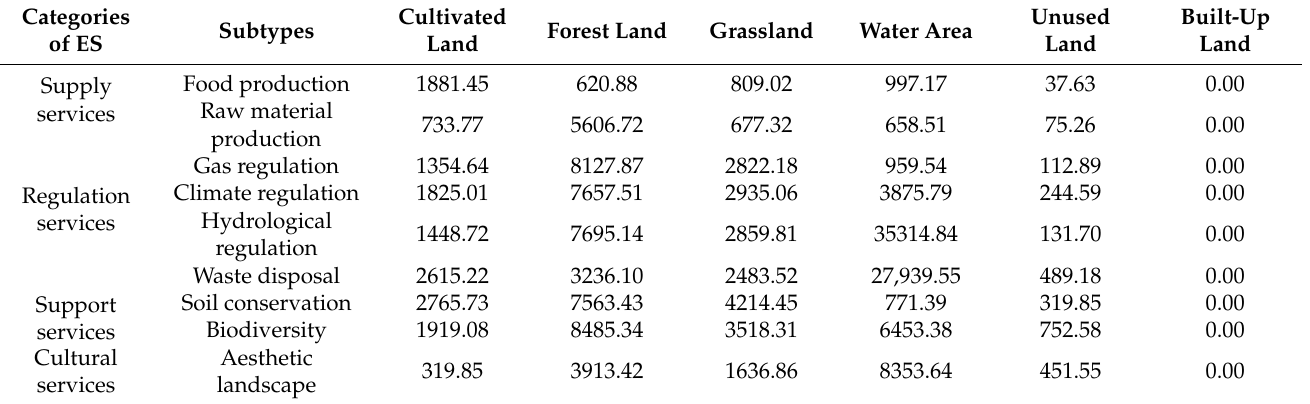
Table 2. Equivalent value per-unit area of ES by land use type in the HRB of Hubei Province (Unit: CNY/hm 2